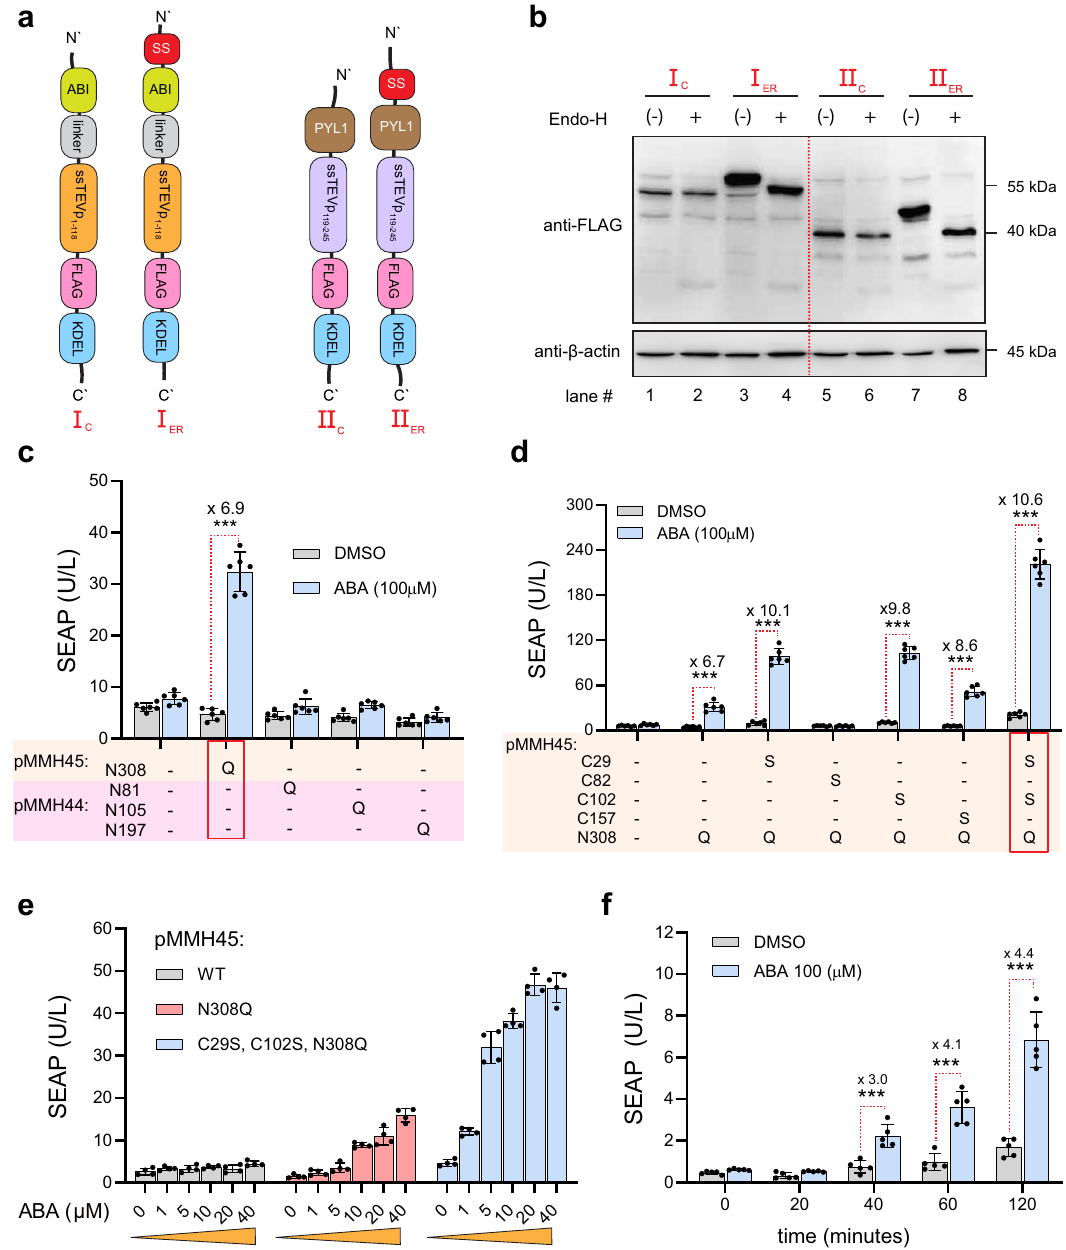
Fig. 3 | Engineering an ef fi cient ER-localized ABA-inducible fast-release system through combinatory mutagenesis of C and N residues in CIDs to circumvent functionallydetrimental PTMs. a Structure depiction of the cytoplasmic and the ER-localized versions of ABI-ssTEVp 1 – 118 and PYL1-ssTEVp 119 – 245 , annotated as I c (pPW32), I ER (pPW34), II c (pPW33), and II ER (pPW35). A secretion signal (SS) was introduced into I ER and II ER fusions. All constructs were tagged with FLAG for fur- ther analysis. b Immunoblotting against FLAG tag of HEK-293 cells transfected separatelywiththeI c ,I ER ,II c ,orII ER followingendo-Htreatmentofthetotallysates. Actinwasusedasaloadingcontrol. c Site-directedmutagenesisofER-localizedABI- ssTEVp 1 – 118 and PYL1-ssTEVp 119 – 245 fusion proteins. SEAP levels in culture super- natants of HEK-293 cellstransfected with 5ng pMMH10,whichencodesSEAP-TCS- KDEL(P hCMV -SEAP-TCS-KDEL-pA),inadditionto5ngofdifferentNtoQmutantsof pMMH44 (P hCMV -SS-PYL1-ssTEVp 119 – 245 -KDEL-pA bGH ) and pMMH45 (P hCMV -SS-ABI- (GGGGS) 2 -ssTEVp 1 – 118 -KDEL-pA bGH ). Data are presented as mean±SD of n =6 bio- logically independent samples. *** P <0.0001 was calculated using two-tailed,